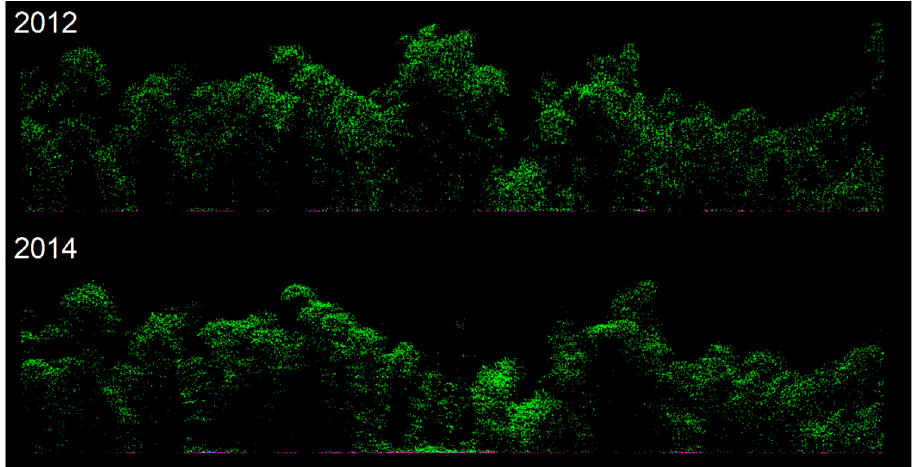
Figure 2. A horizontal transect of the point cloud depicting a region of the forest subjected to selective logging between 2012 and 2014 after having been classified and normalised.